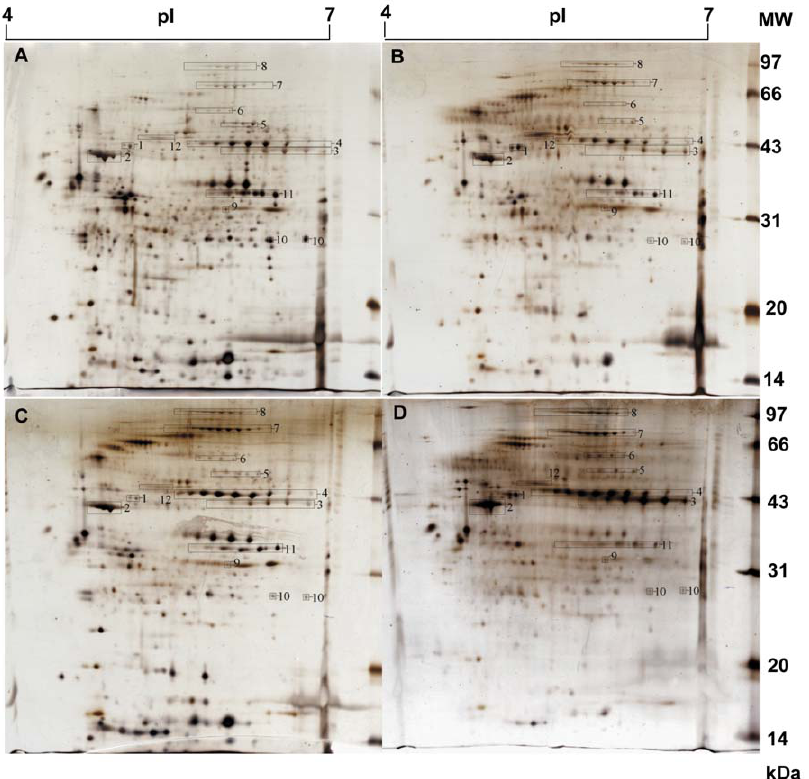
Figure 2. The 2-DE images of the cytoplasm proteins from T.maritima cultured at the four temperatures. A), B), C), and D) exhibit the 2- DE images for the bacteria cultured at 60, 70, 80 and 90 u C, respectively.